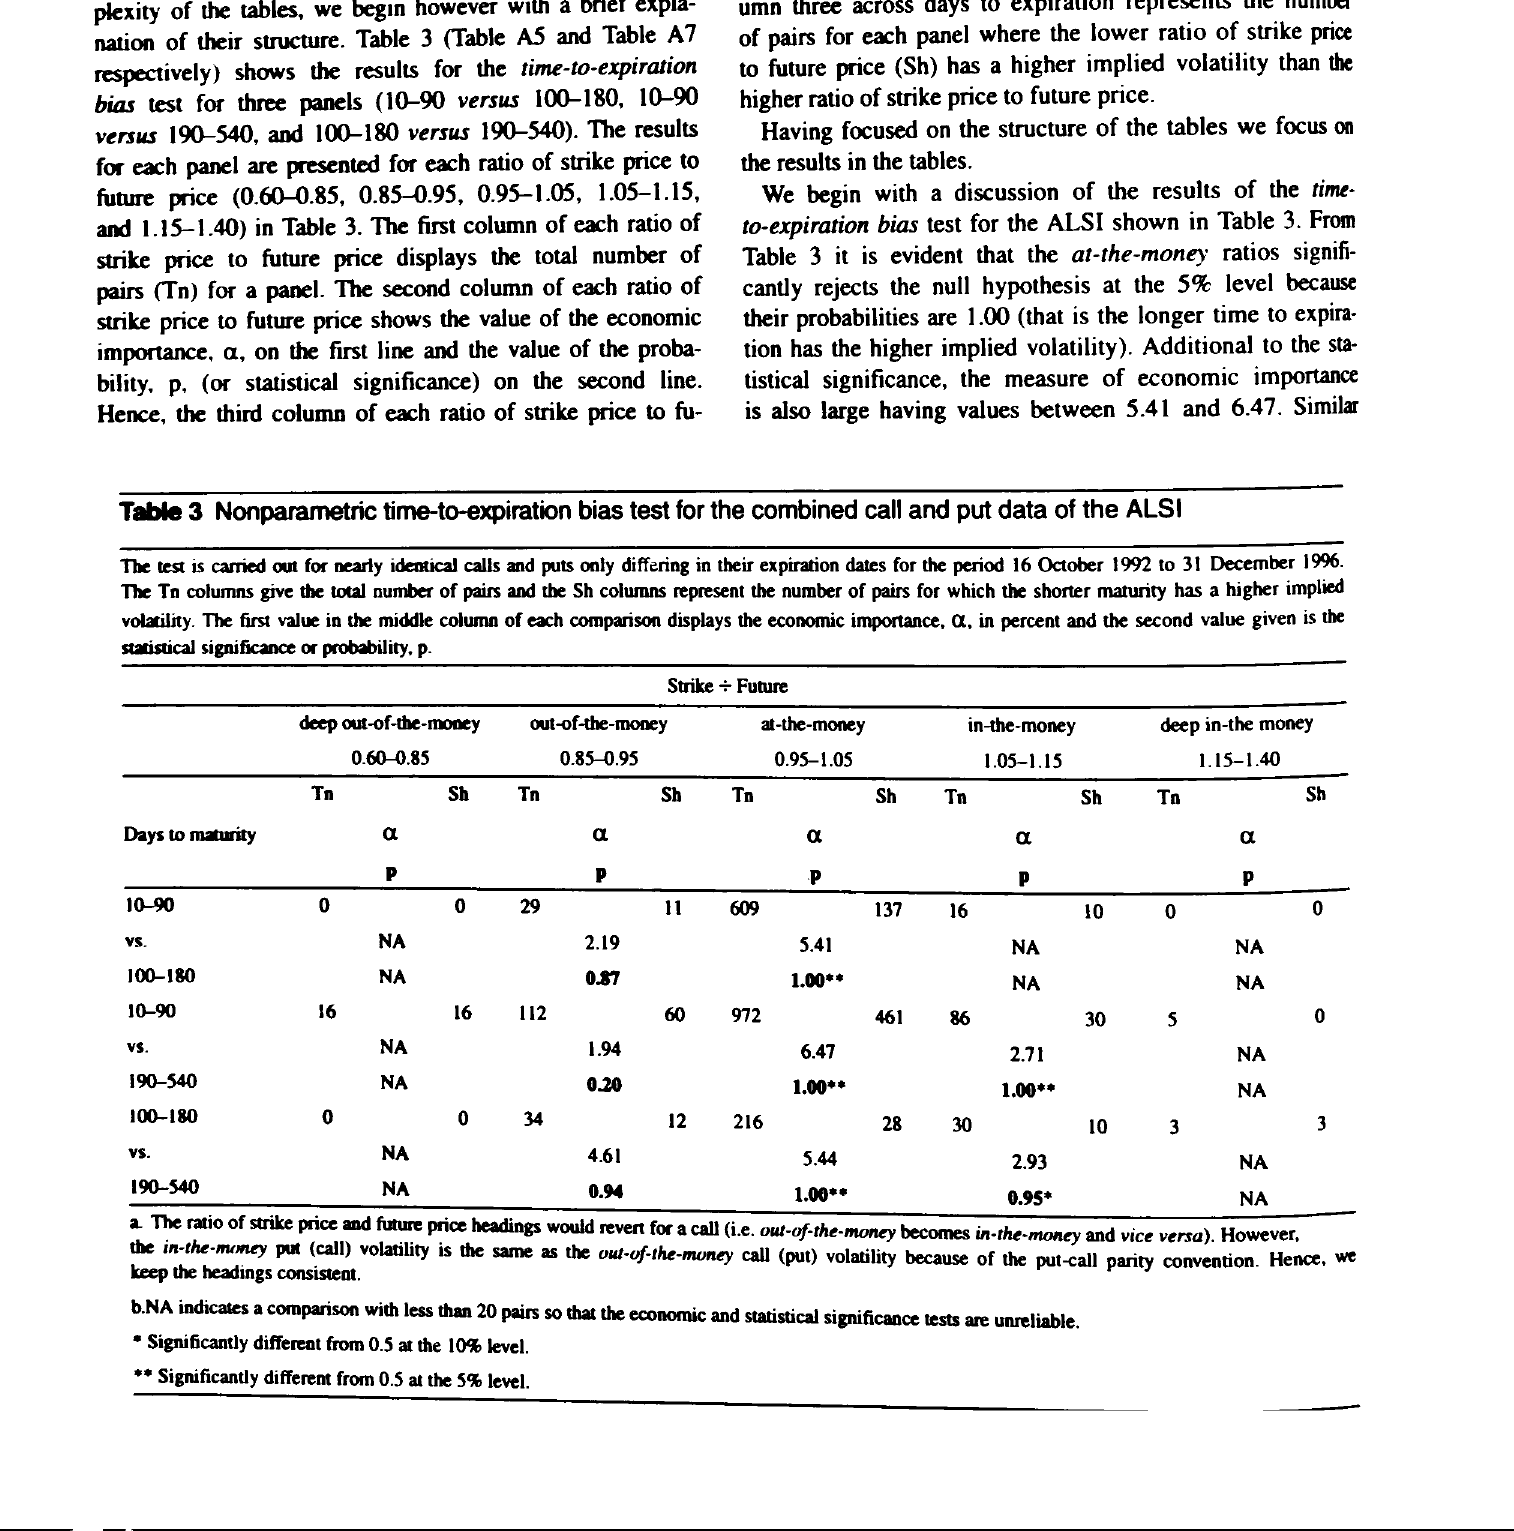
Table 3 Nonparametric time-to-expiration bias test for the combined call and put data of the ALSI The rest is carried out for nearly ideotical calls and puts only differing in their expiration dates for the period 16 October 1992 to 31 December 1996. The Tn columns give the total number of pairs and the Sh columns represent the number of pairs for which the shorter maturity has a higher implied volatility. The first value in the middle column of each comparison displays the economic importance, a. in percent and the second value given is the Slalistical significance or probability.